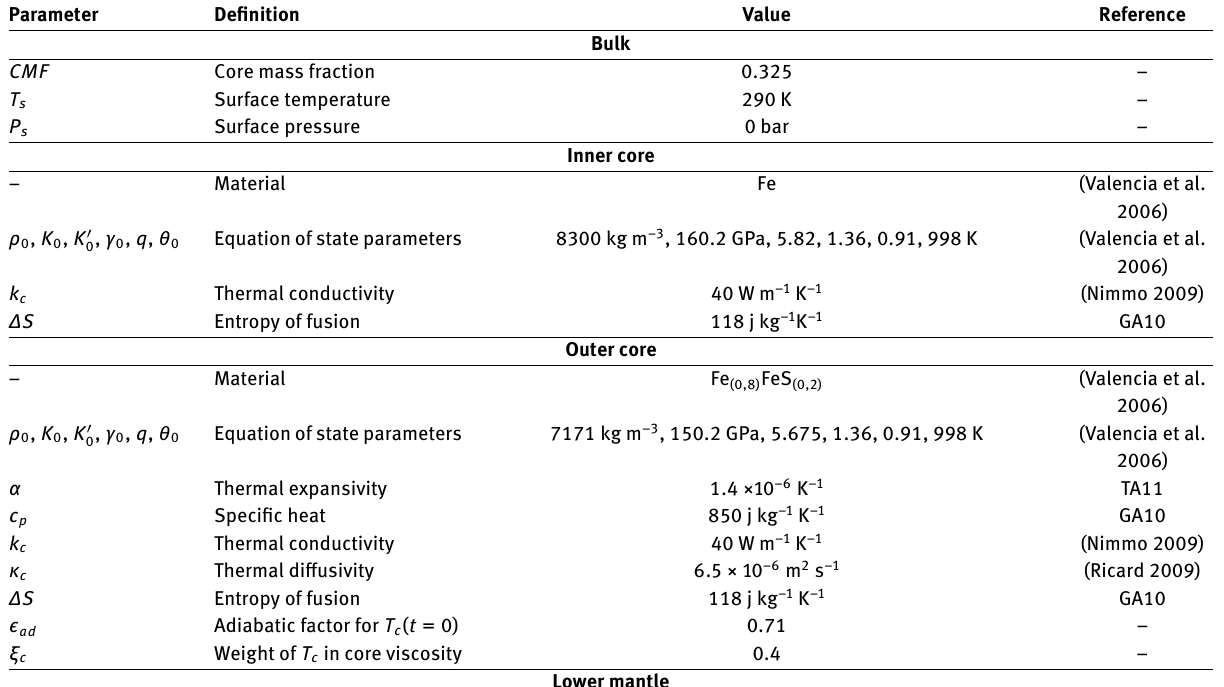
Table 3. Interior structure and thermal evolution model parameters